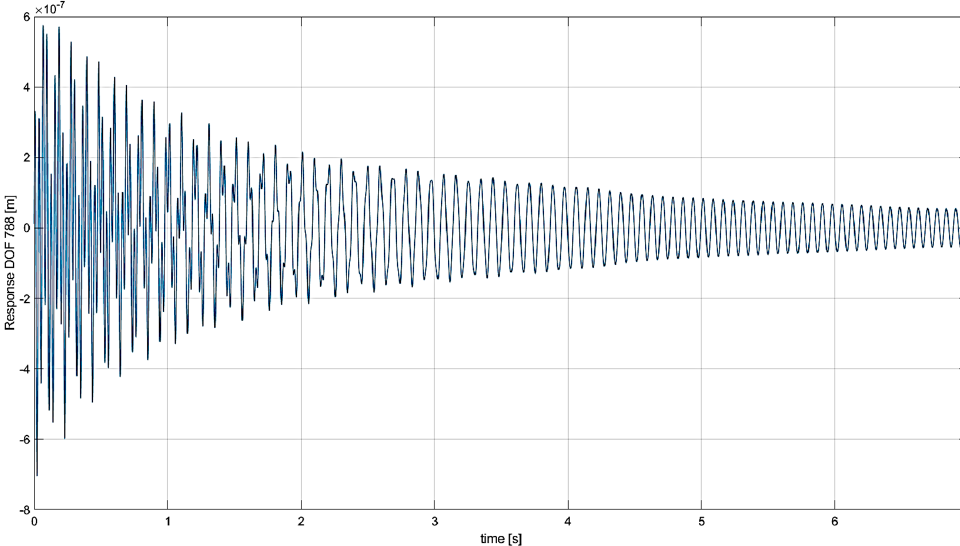
Figure 37. Nosecone deflection without loading.